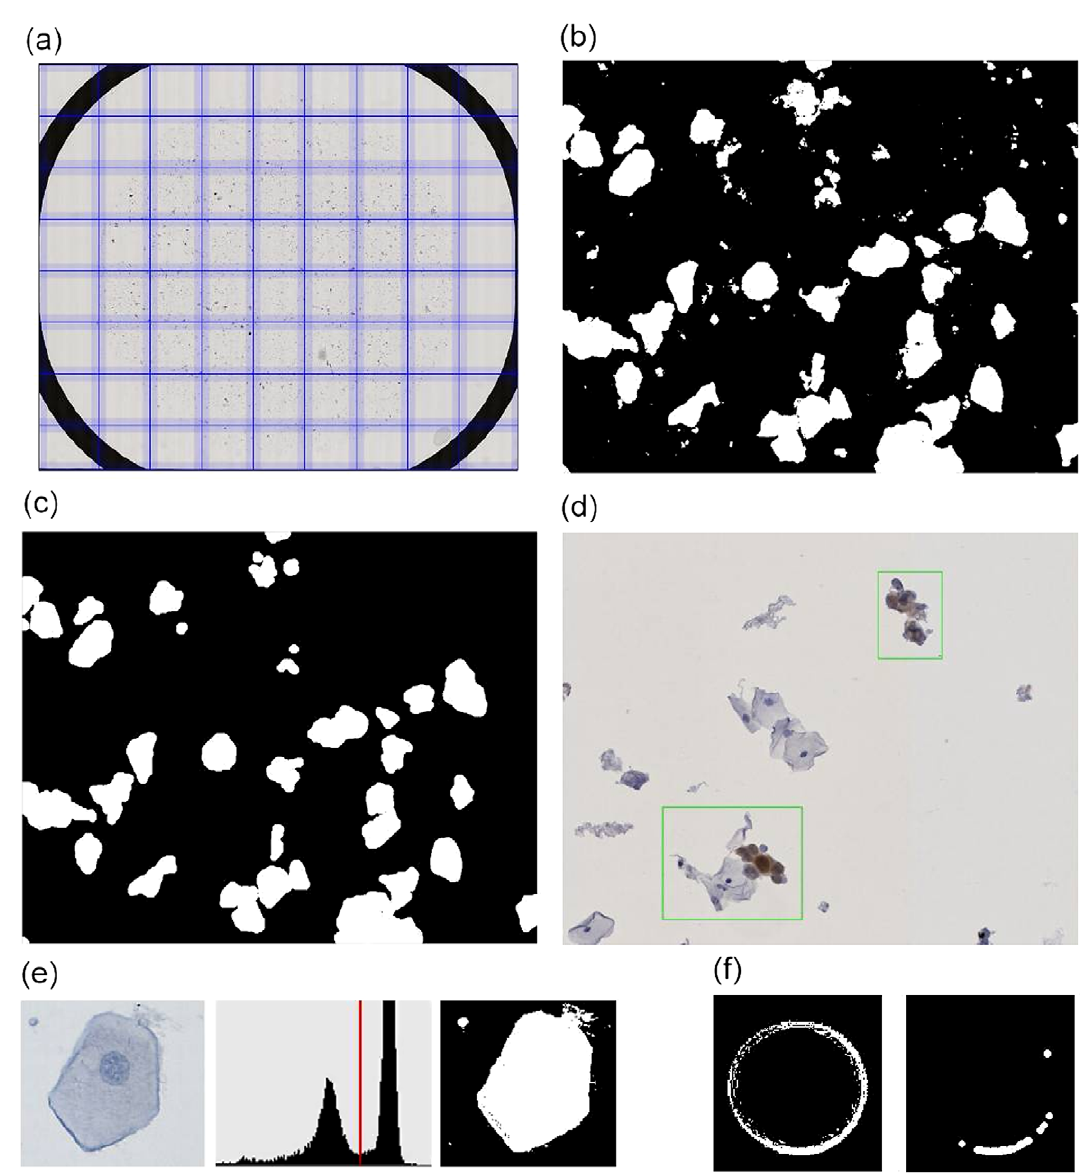
Fig. 2. Illustration of object detection. (a) Virtual slides of 65,000 × 50,000 pixels size are tiled into 2000 × 2000 pixel sized subimages for image processing, (b) object detection yields potential cell clusters (white), (c) erosion and dilation removes small objects, (d) detected cell clusters are annotated as a green frame in the original and non-tiled virtual slide, (e) object detection by Otsu method which separates background and object via a threshold in the intensity histogram, (f) small air bubbles are removed by erosion and dilation and a minimal cell size